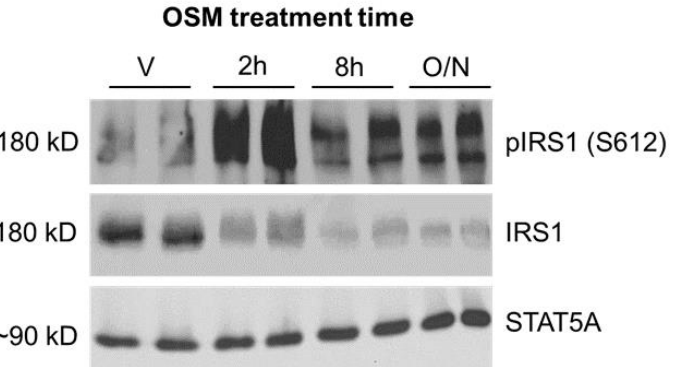
Figure 2. OSM induces inhibitory phosphorylation of IRS1 at serine 612 (S612). 3T3-L1 adipocytes were exposed to 0.5 nM OSM for 2 h, 8 h, or overnight (~16 h). Cells were harvested after OSM exposure, and lysates were subjected to immunoblotting for phospho-IRS1 (S612) and total IRS1; STAT5A was used as a loading control. OSM stimulated inhibitory IRS1 phosphorylation of S612 at all time points depicted. The immunoblot pictured here represents results from two independent experiments, each with 3 wells per condition (n = 6 total wells per condition).